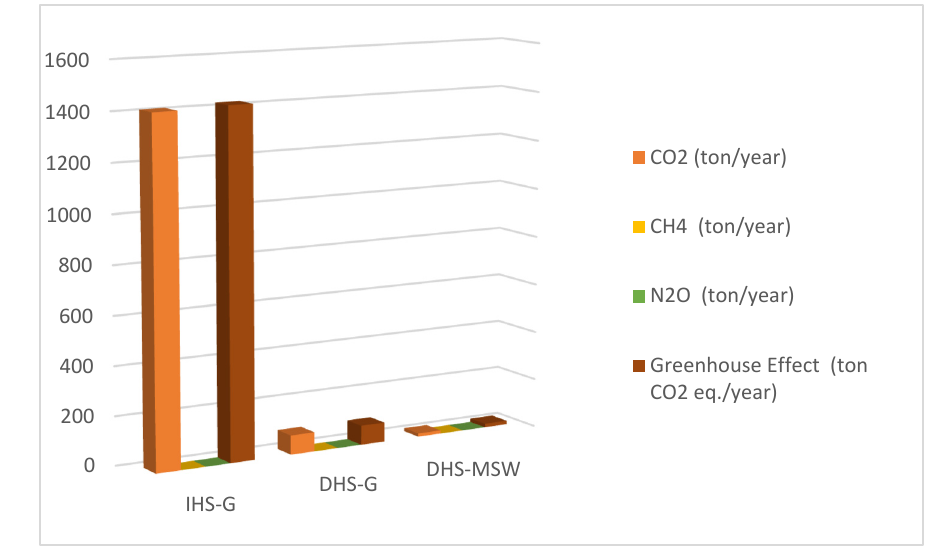
Table 18. The GHG emission and the greenhouse effect of the three scenarios.